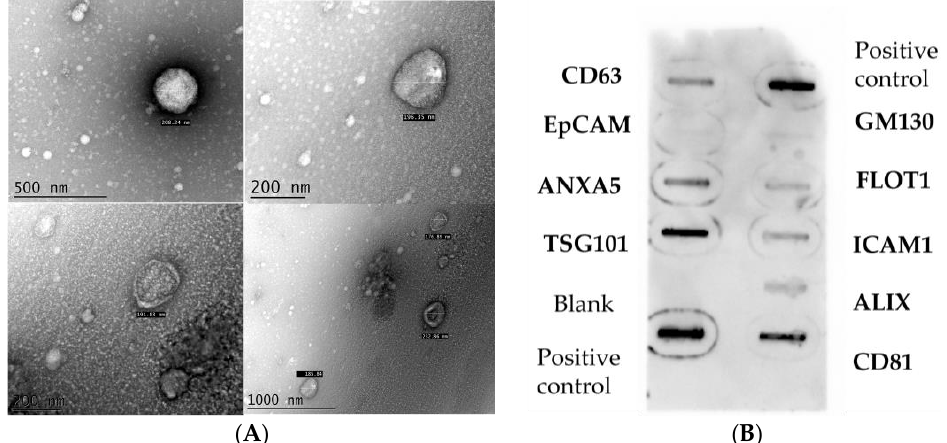
Figure 1. Morphology of the EVs through TEM and the expression of specific EVs markers. ( A ) The morphology and size of EVs using TEM; ( B ) Identification of specific EVs´ markers using the Exo- Check Exosome antibody Array ™ .